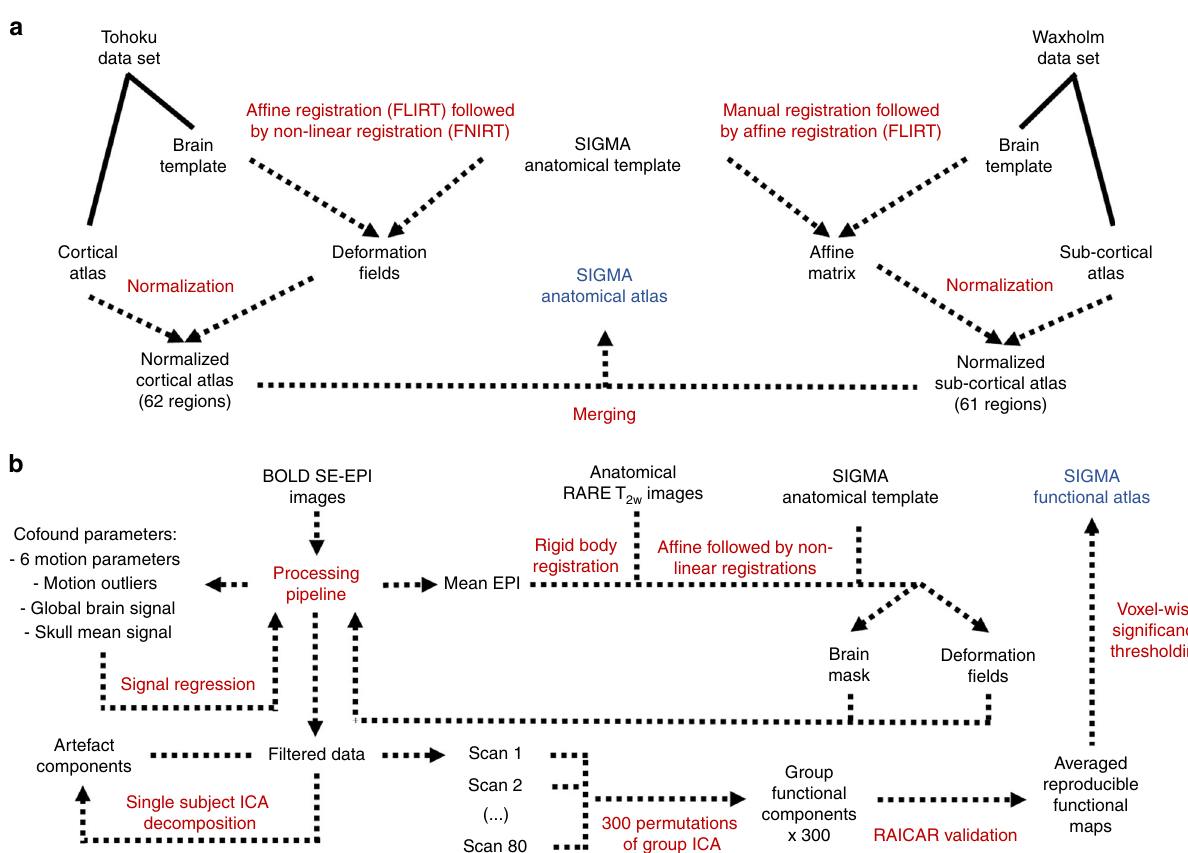
Fig. 8 Schematic of the work fl ows developed to create SIGMA atlases of rat brain. Work fl ows used for the creation of a the ex vivo SIGMA anatomical atlas of rat brain and b the in vivo SIGMA functional